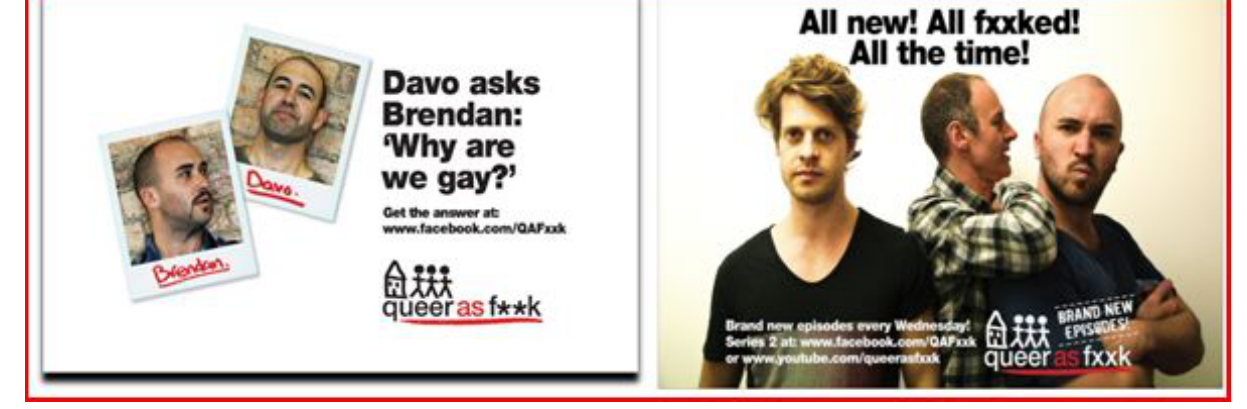
Figure 2. Press ads in gay community magazine used for promotion of QAF